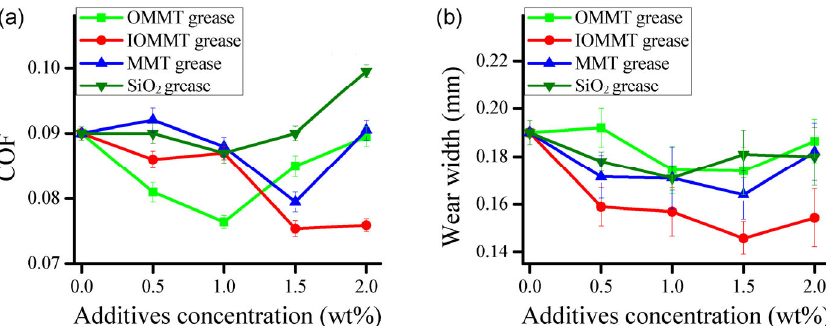
Fig. 5 The average COFs (a) and wear widths change (b) under the lubrication with insulating greases at different additives concentrations at 50 N, 5 Hz, and